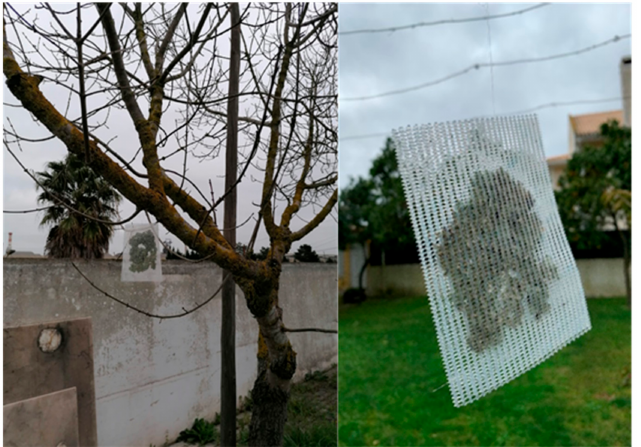
Figure 2. Exposed transplanted Flavoparmelia caperata lichens in nylon bags ( right ) that were placed in the study area ( left